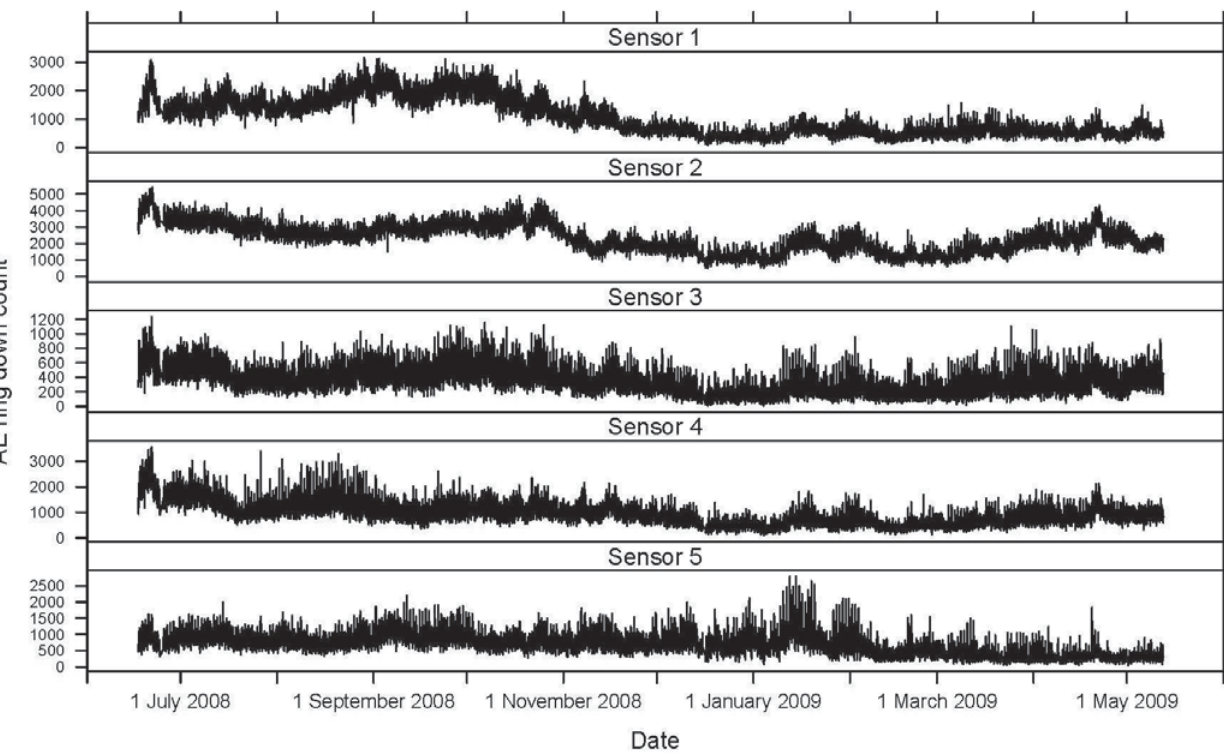
Figure 1. A continuous record of the acoustic emission (AE) ring down count for each sensor (1 – 5), from 15 June 2008 to 15 May 2009, displays a seasonal cycle. The AE ring down counts for the untreated checks (sensors 6 and 7), logs with no live termites, are displayed for